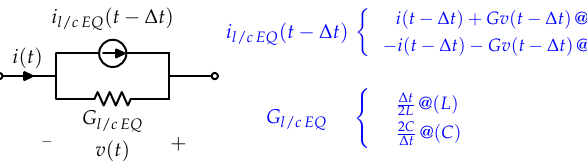
Figure 3. EMT equivalent representation of lumped